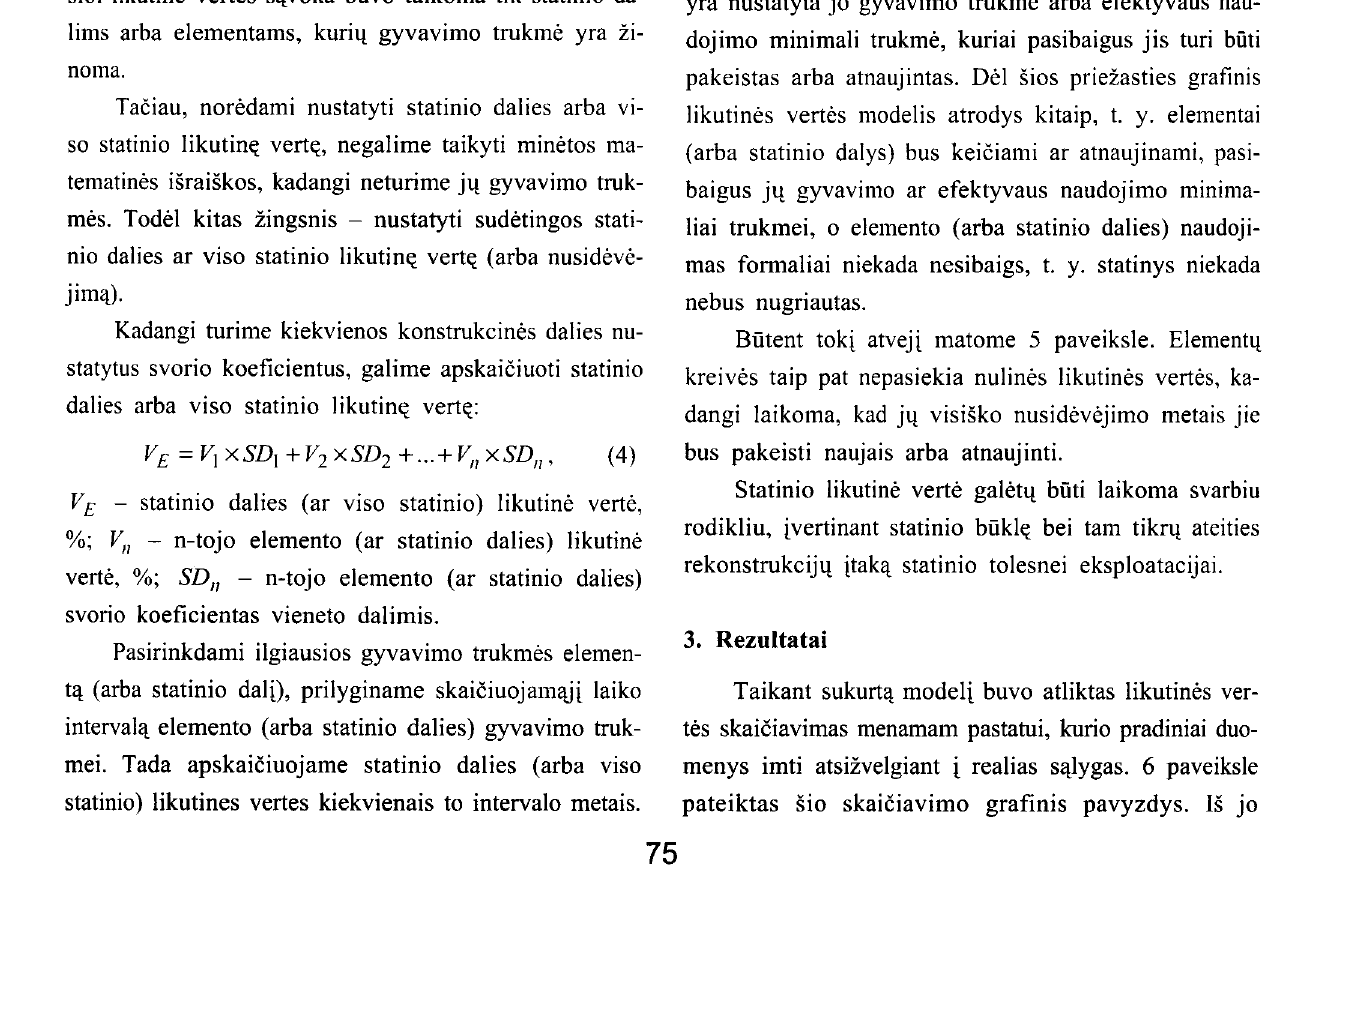
3 paveiksle matome likutines vertes pasiskirstymo kreivi4 variantus, esant skirtingoms d ir c reiksmems.